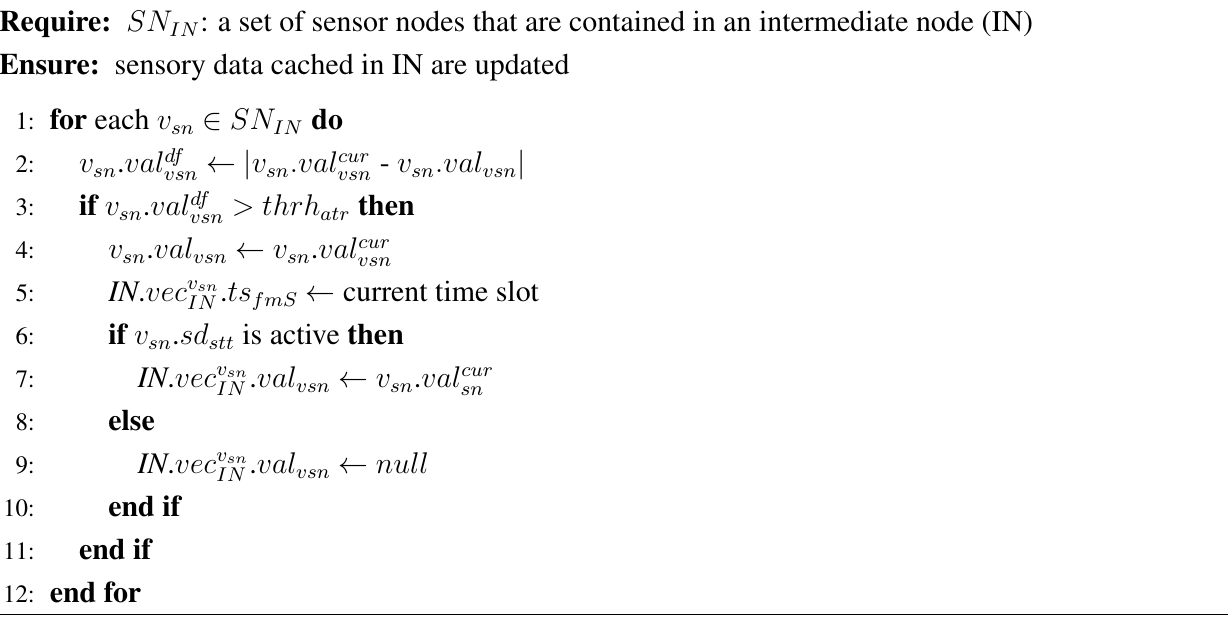
Algorithm 2 Data